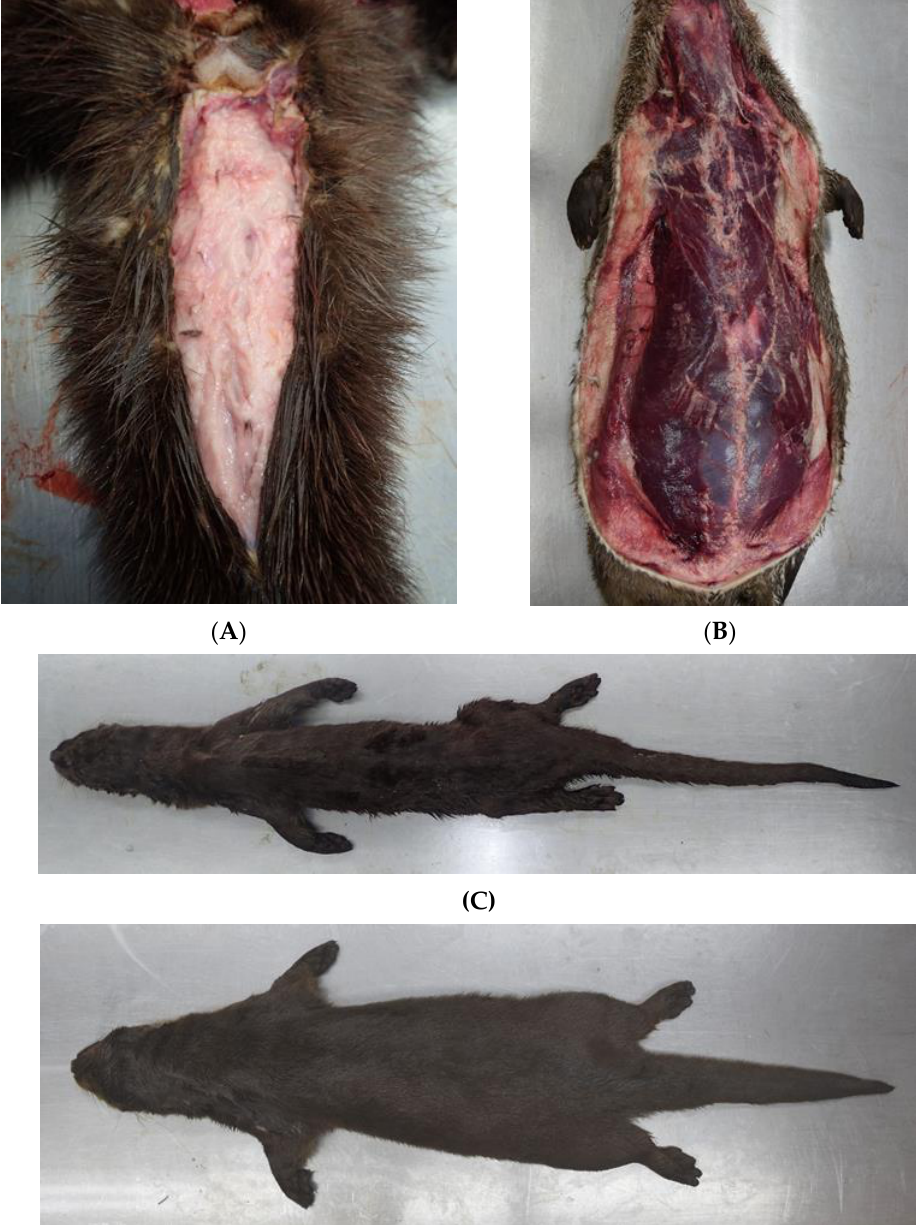
Figure 2. Otter in good nutritional status with a lot of subcutaneous fat in the tail radix region ( A ) and along the body ( B ). Severely emaciated otter ( C ) in comparison to an individual in good body condition ( D ).